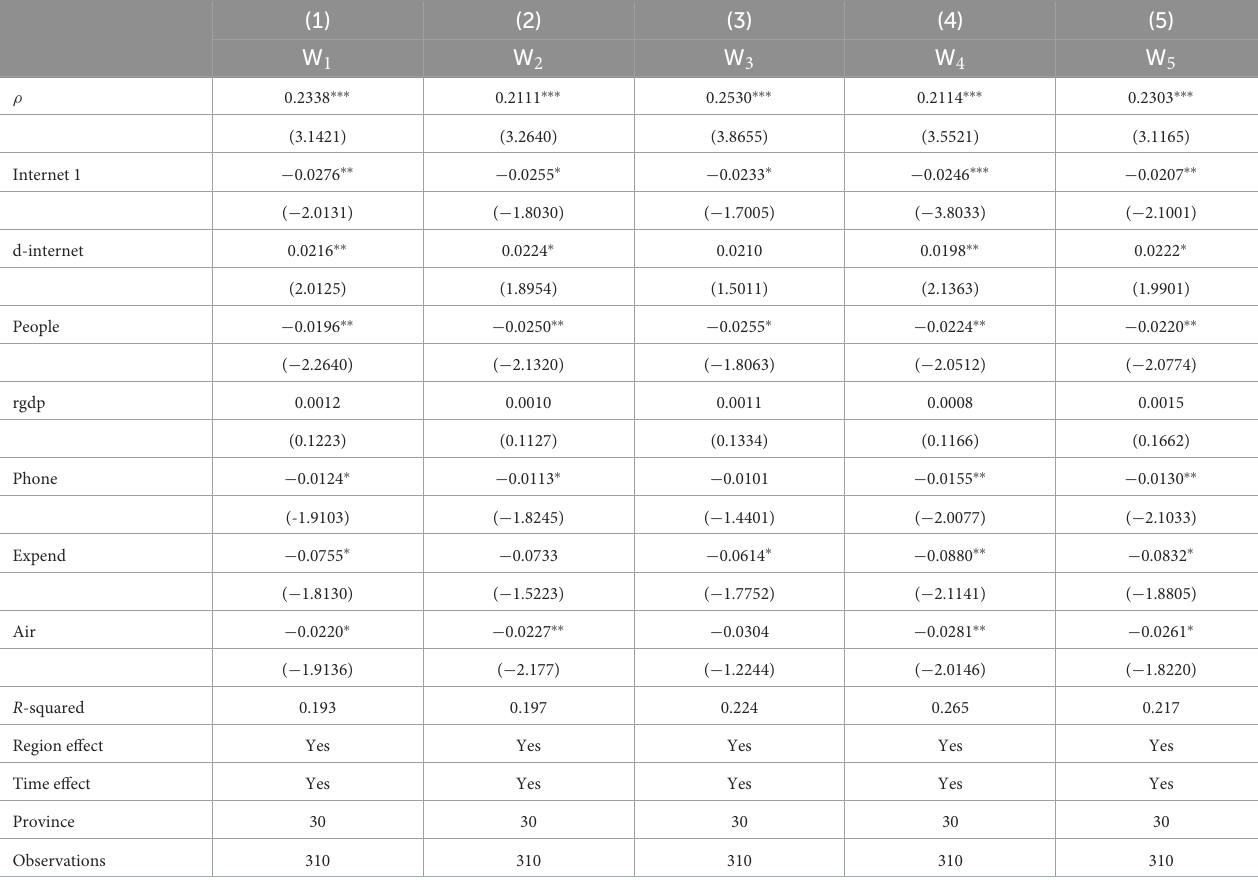
TABLE 4 Panel regression results of the Durbin